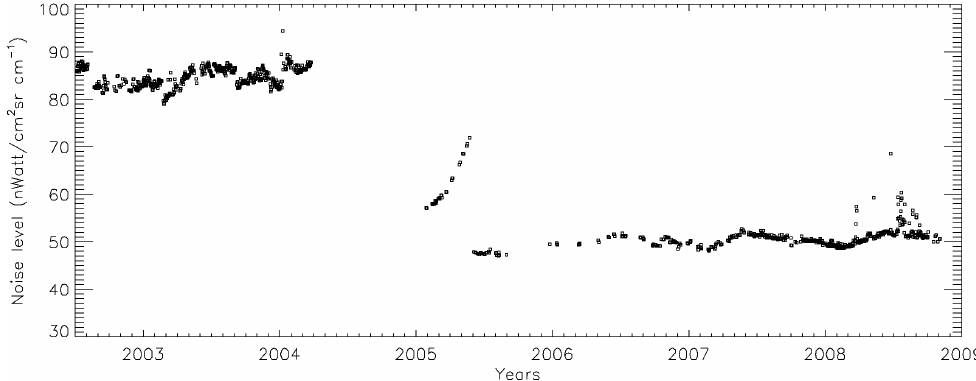
Fig. 2. MIPAS noise level for a 10cm − 1 wide spectral region centered at 690cm − 1 for the full MIPAS mission as a function of the acquisition